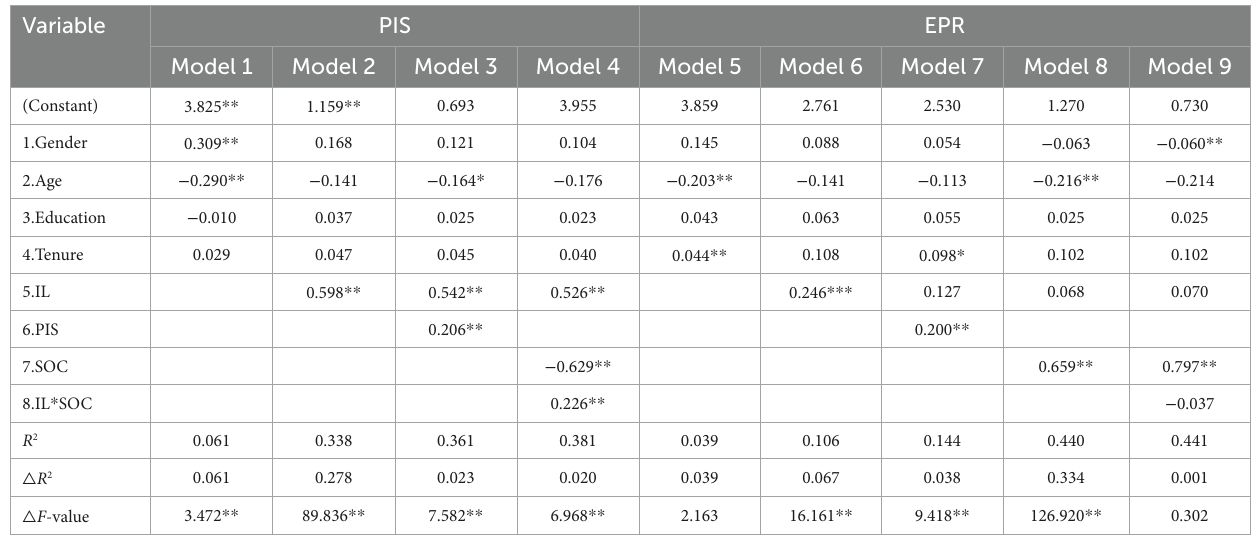
TABLE 4 Hierarchical regression result. Variable